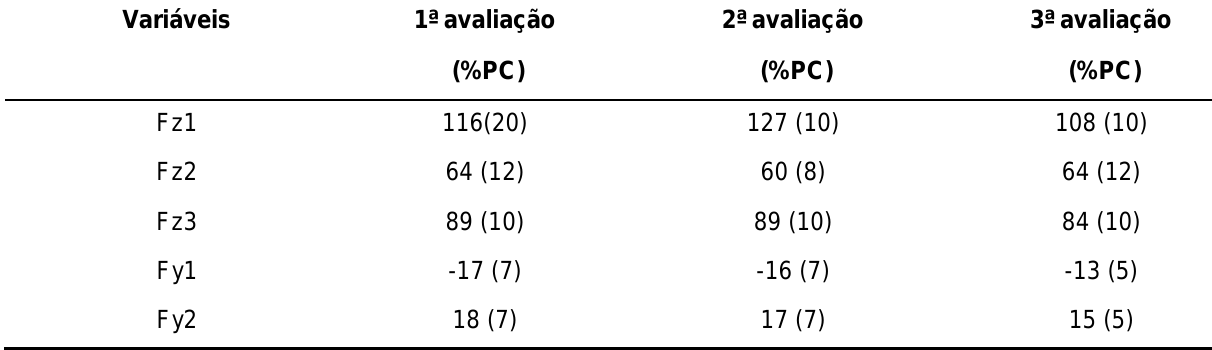
Tabela 2. Valores médios (desvios-padrão) das variáveis discretas das forças de reação do solo, normalizadas pelo peso corporal.